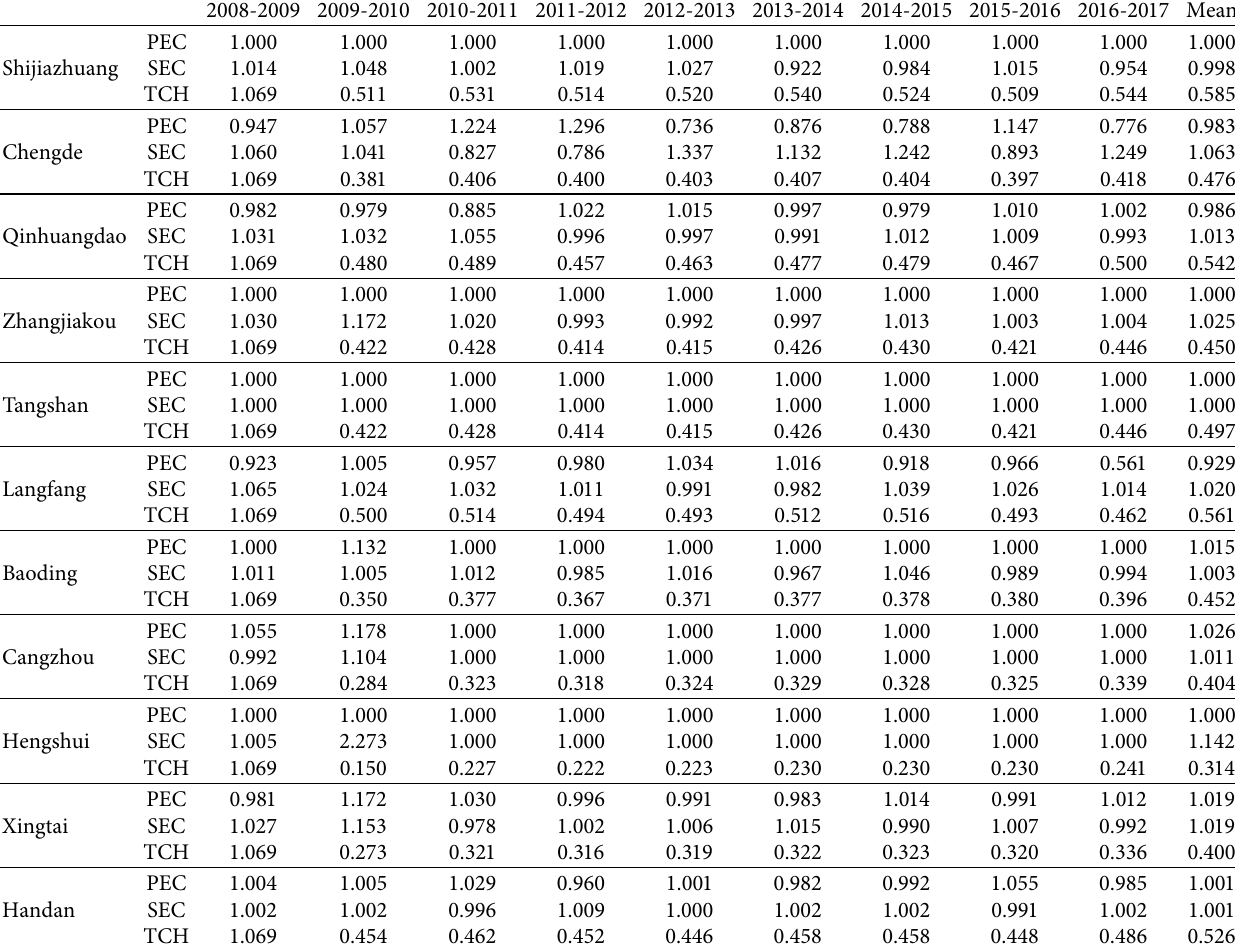
Table 1: PEC, SEC, and TCH of service industries Hebei Province (2008 ∼